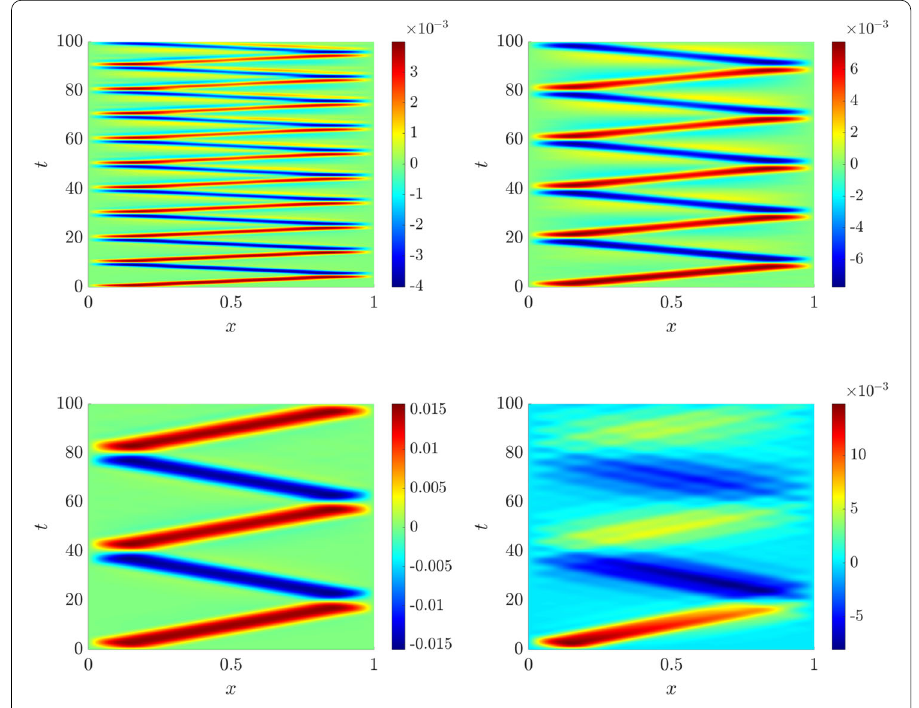
Fig. 7 Space–time solutions for κ = 25 , 100 , 400 , 500 (left–right, top–bottom)